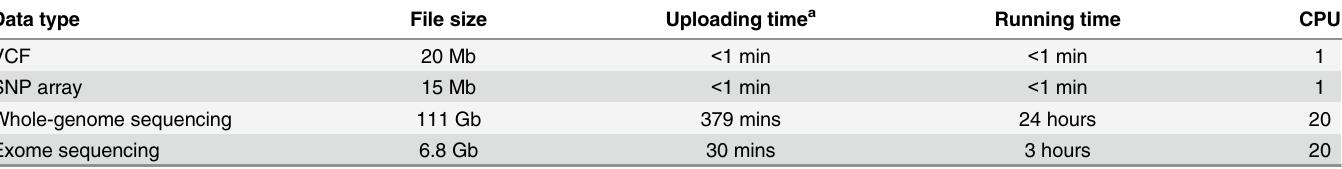
Table 1. VP running time with various input